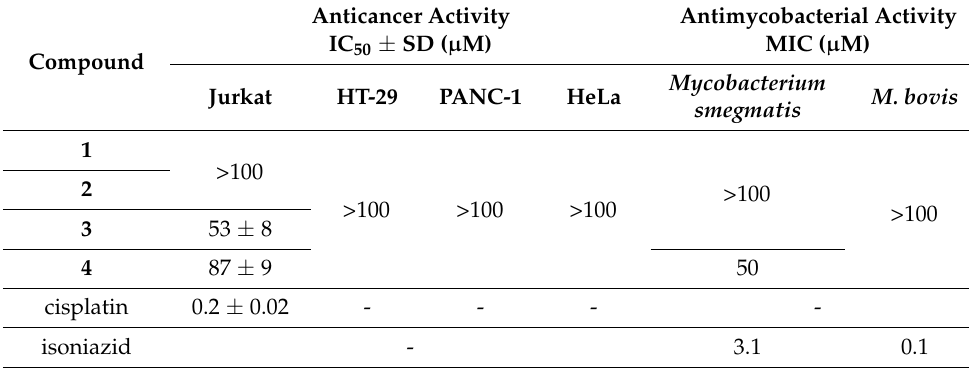
Anticancer Activity IC 50 ± SD ( µ M)